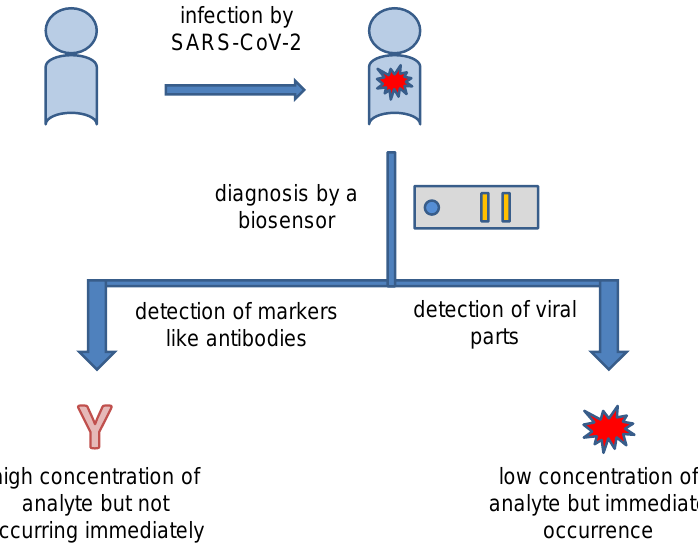
Figure 2. General concept of the diagnosis of COVID-19 by biosensors.